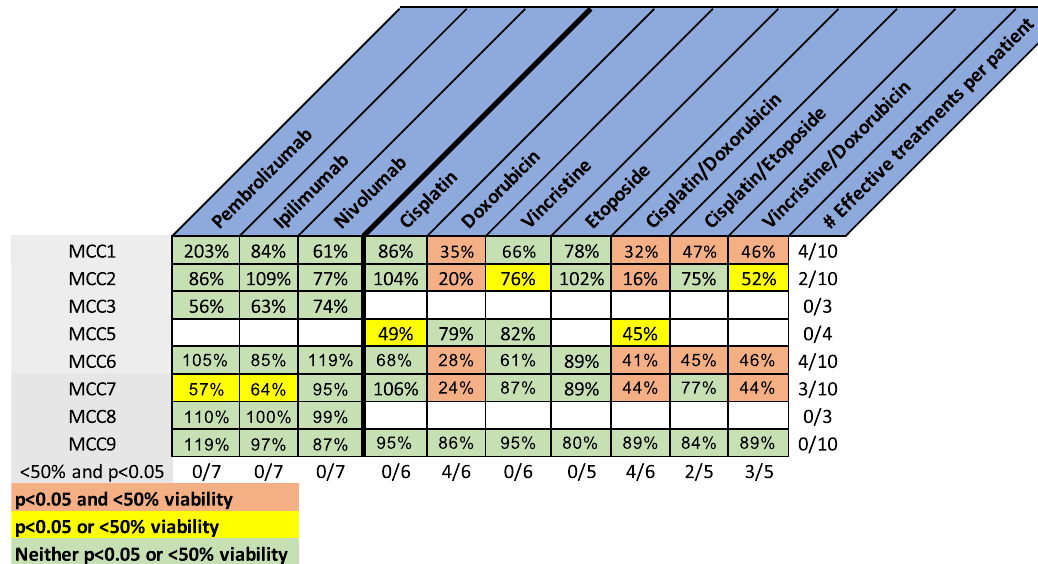
Figure 3. Chemotherapy screening of PTO demonstrates intertumor heterogeneity in tumor treatment response. Percentages are viability compared to patient matched control organoids. Doses for treatments in table are as follows: cisplatin (10 uM), doxorubicin (1 μM), vincristine (1 μM), etoposide (1 μM), cisplatin/ doxorubicin (10 μM/1 μM), cisplatin/etoposide (10 μM/1 μM), and vincristine/doxorubicin (1 μM/1 μM). Green boxes represent treatments resulting in < 50% viability decrease and p > 0.05, yellow boxes > 50% or p < 0.05, red boxes represent treatments with > 50% viability decrease and p < 0.05. The bottom line is number of PTO sets in which the treatment is effective (< 50% viable and p < 0.05). The column on the far right represents the number of effective treatments in the respective patient organoid